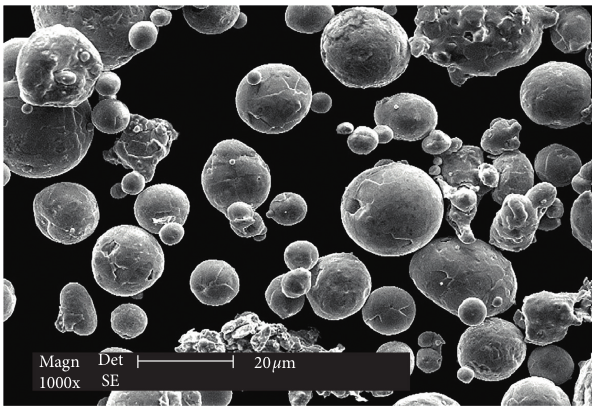
Figure 1: SEM morphology of Ni45 powders.